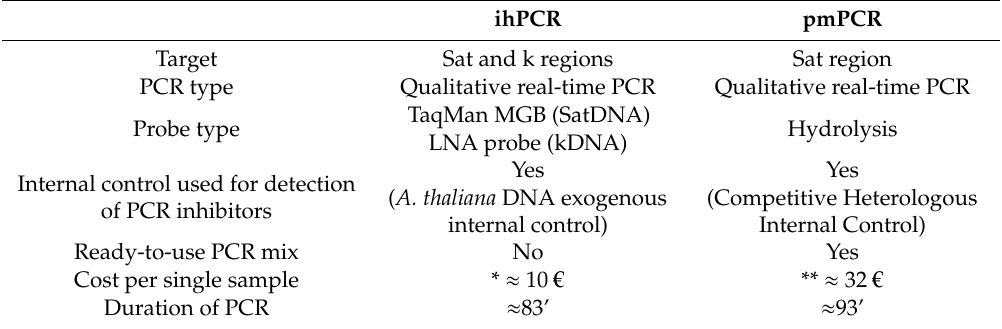
Table 2. Technical characteristics of the in-house PCR and the RealCycler ® CHAG kit (Progenie